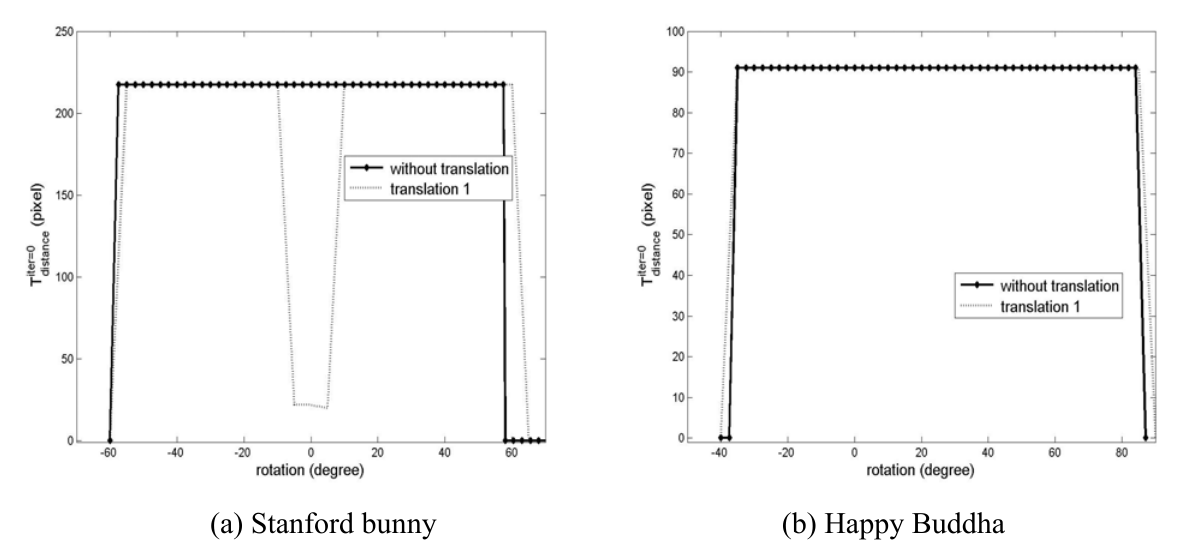
Figure 12. Initial thresholds for distance, i.e. Stanford bunny and the happy Buddha using the GP-ICP without